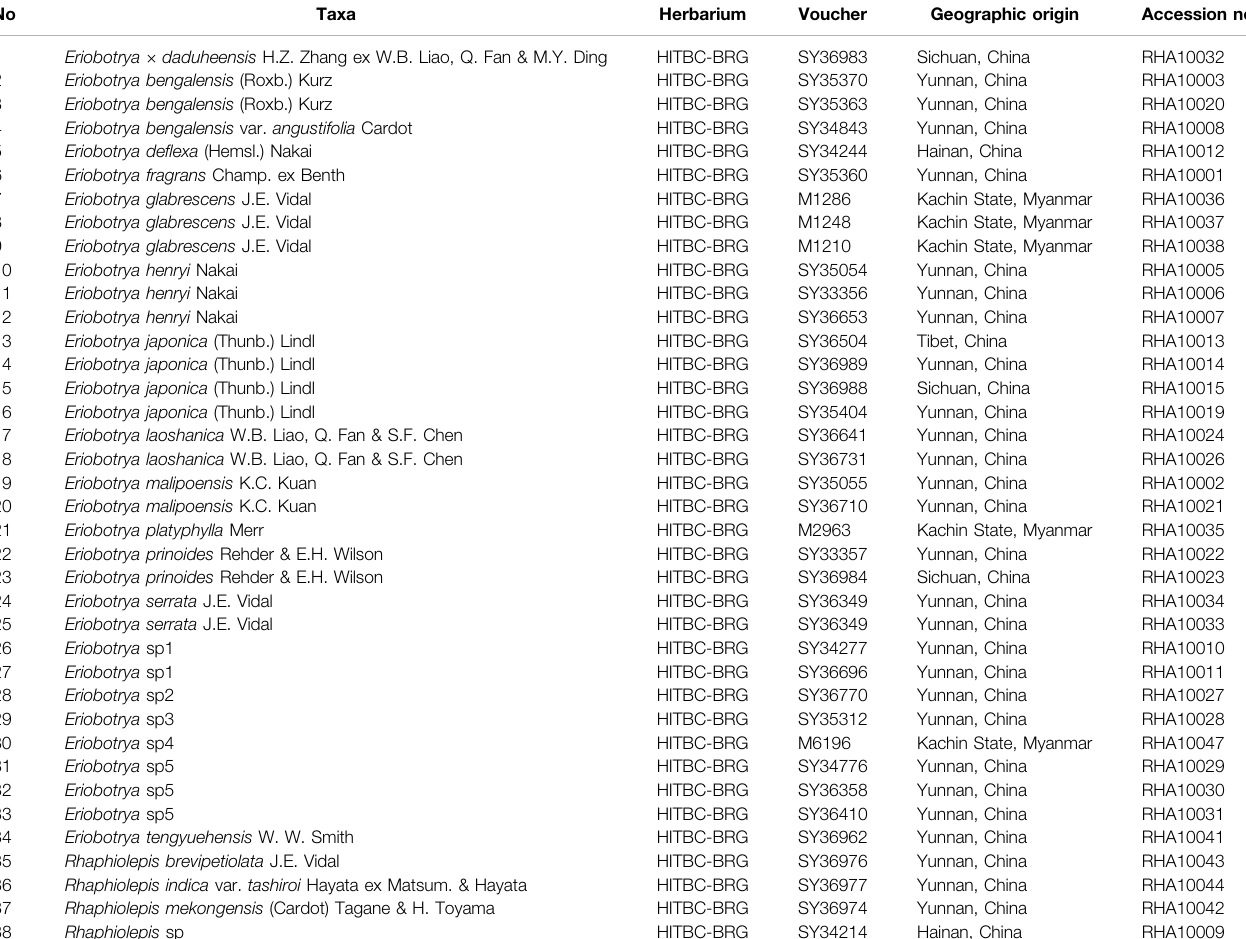
TABLE 1 | List of samples, voucher collection information, and accession